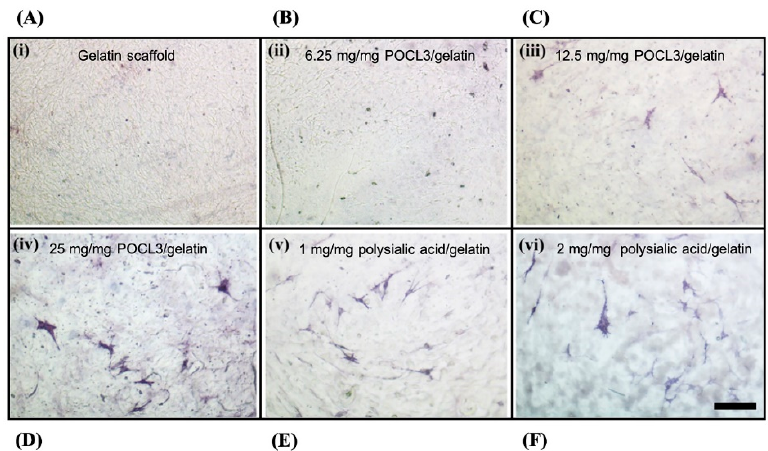
Figure 3. The alkaline phosphatase staining of murine mesenchymal stem cells (C3H10T1/2) on SBF mineralized gelatin scaffolds. ( A ) Gelatin scaffold only. ( B – D ) 6.25, 12.5 and 25 mg/mg POCl3 incorporated with gelatin scaffolds, respectively. ( E – F ) 1 and 2 mg/mg polysialic acid incorporated with gelatin scaffolds, respectively. The staining showed osteogenic differentiation of stem cells on mineralized scaffolds. Scale bar: 100 µm. Adapted with permission from [11].